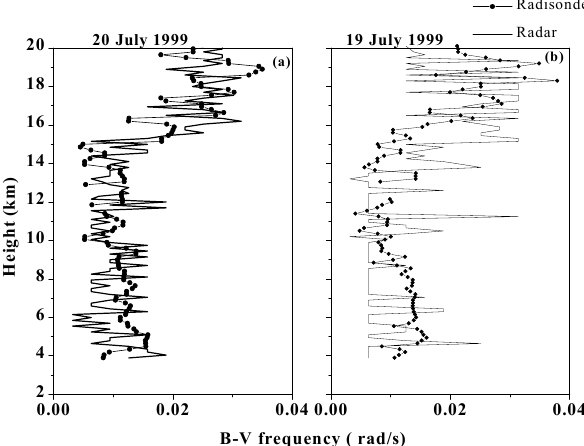
Fig. 2. Comparison of identified radar Brunt-V¨ais¨al¨a frequencies from the radar vertical velocities with the calculated Brunt-V¨ais¨al¨a frequencies from the radiosonde (a) on a clear day (20 July 1999) and (b) on a cloudy day (19 July 1999).